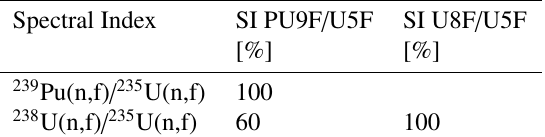
Table 7: Experimental correlations for Heaton et al. [25].